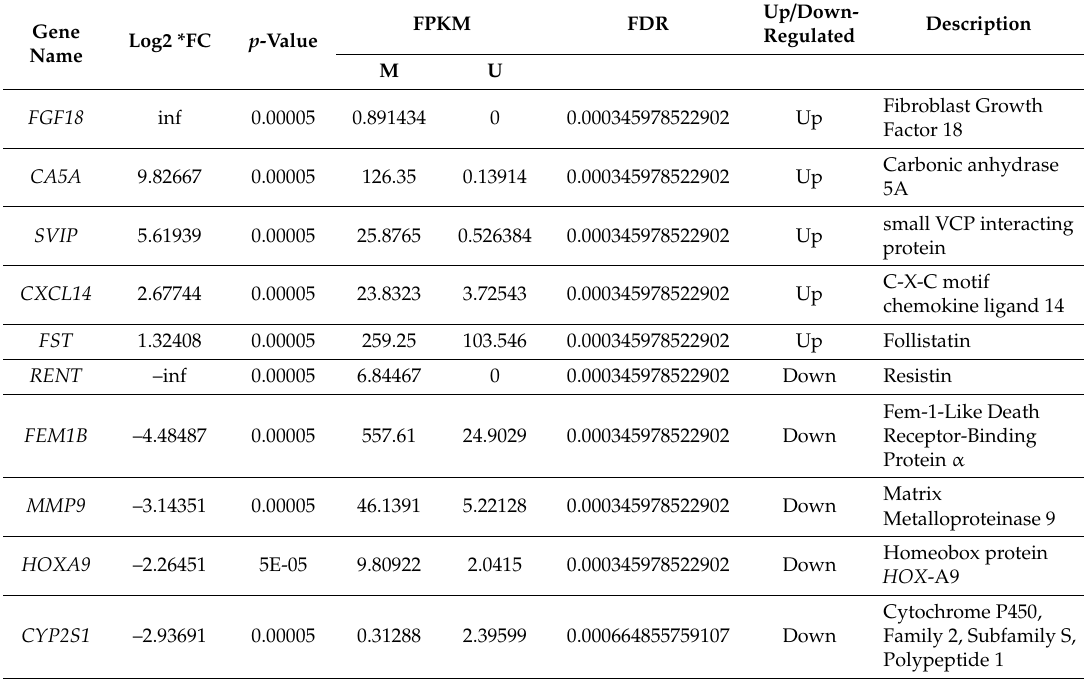
Table 3. The top 10 most significantly a ff ected genes in ewes with two lambs per birth compared with one lambing per birth.